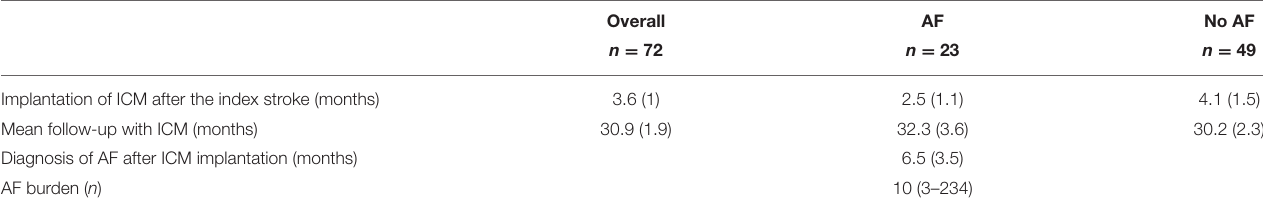
TABLE 2 | Insertable cardiac monitor (ICM) data in the overall population and according to the occurrence of AF.